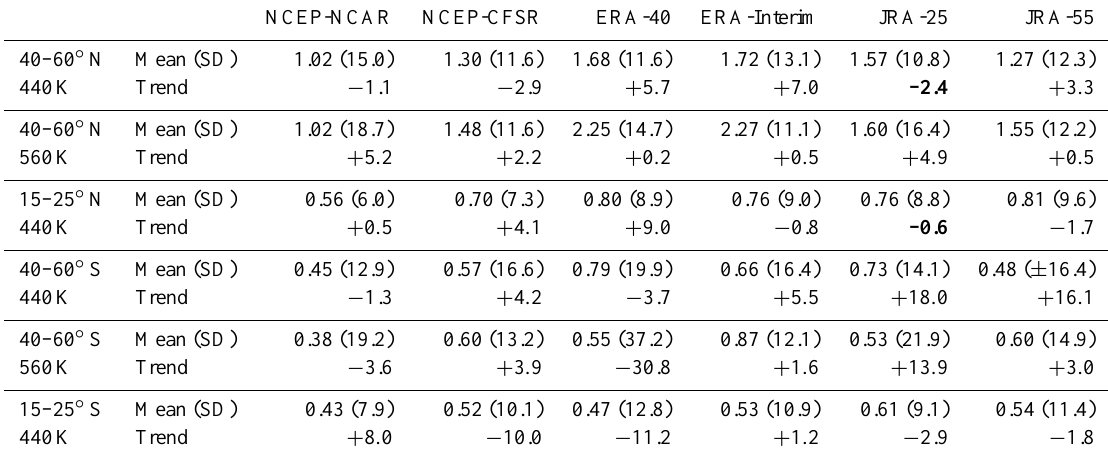
Table 1. Mean value (Mean) over 34 years (1979–2012) of K yy ( l = 1 month) (in 10 6 m 2 s − 1 ) averaged over 40–60 ◦ N at 440 and 560K and over 15–25 ◦ N at 440K in DJF, and averaged over 40–60 ◦ S at 440K and 560 K and over 15–25 ◦ S at 440K in JJA. The standard deviation (SD) is shown in brackets. The linear trend slope (Trend, in %decade − 1 ) is also shown. The linear trend with a confidence level greater than 95% is shown in bold.